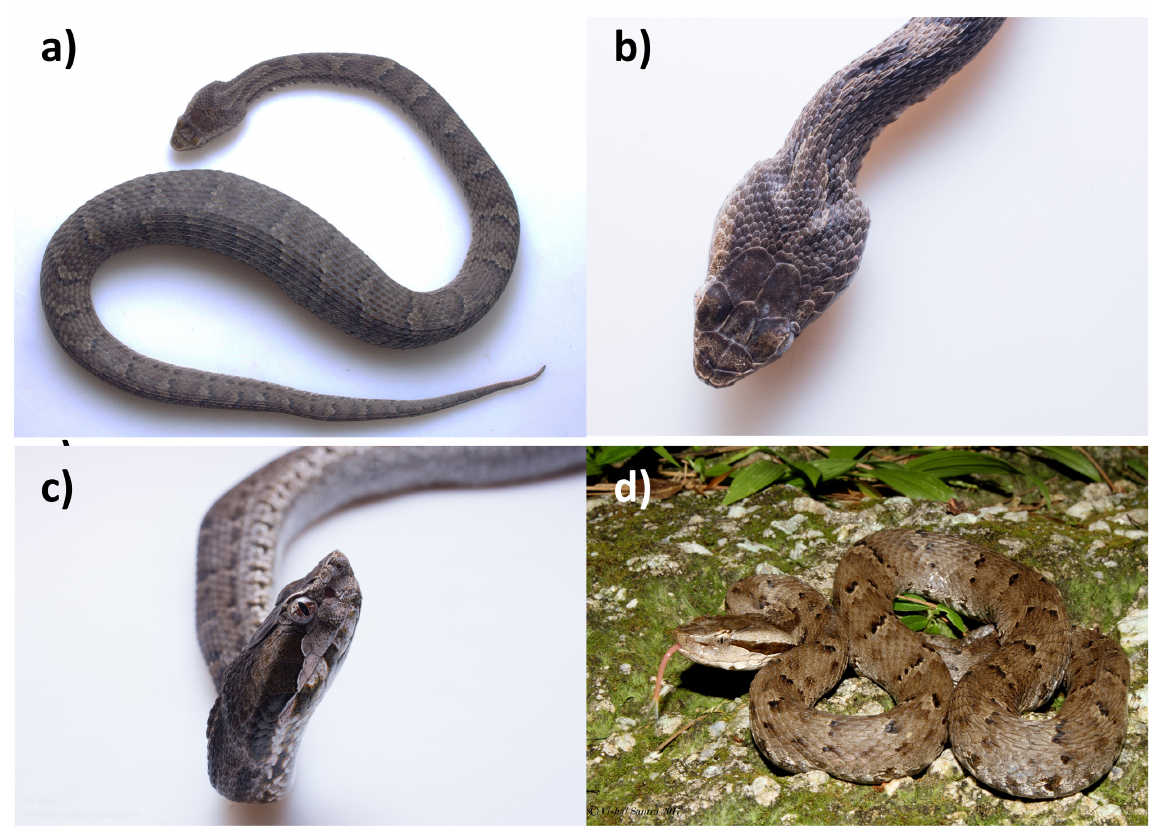
Fig. 8. Gloydius himalayanus (Günther, 1864) . a–c . Male specimen (Great Himalayan National Park, Himachal Pradesh, India; Specimen Number: 18.30). a . Whole body. b–c . Close-up views of the dorsal (b) and lateral (c) head. d . Specimen 17.v03 (Palampur, Kangra), whole body in-situ. Photos provided by J.B. Owens and V.